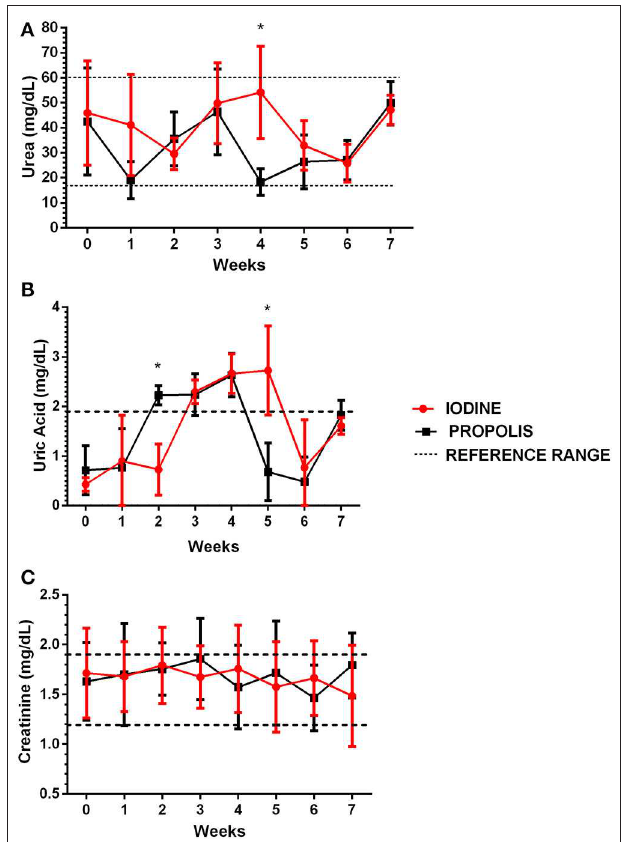
FIGURE 5 | Determination of urea (A) , uric acid (B) , and creatinine (C) in serum samples from animals in the two experimental groups throughout the experiment. The results are presented as mean of each observation time for each group, and the bars indicate their respective standard deviations. The dotted lines represent the reference ranges for urea ( 27), uric acid (28), and serum creatinine (27). Data were compared by the Student t -test, with p < 0.05; no significant difference was found between them.